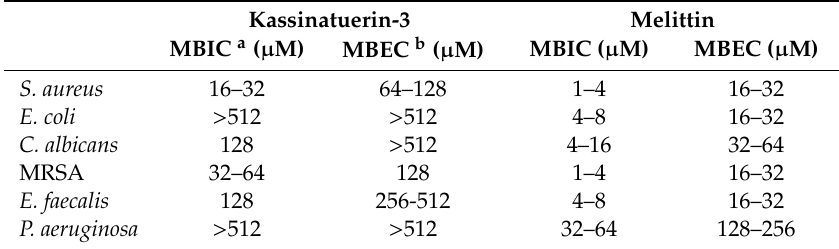
Table 3. Antibiofilm effects of kassinatuerin-3 against selected microorganisms. Melittin was used as a positive control.